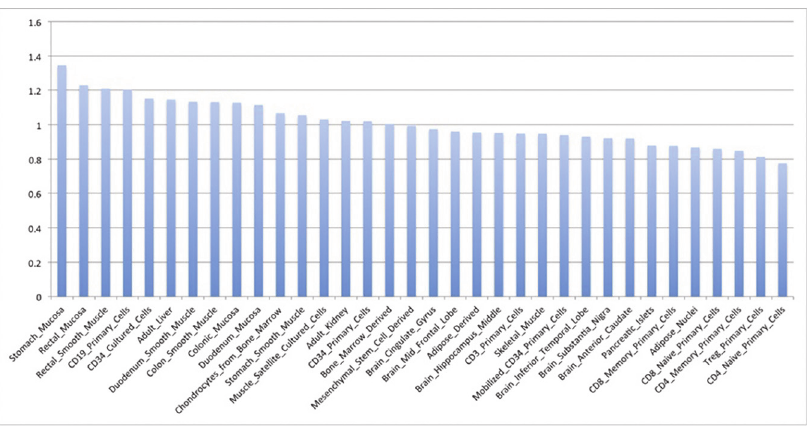
Fig 1. Enrichment of HPV integration sites inside regions marked by H3K4me3 in different cell types. Enrichment for a given cell type is calculated based on overlap between H3K4me3 chip-seq peaks for the cell type and HPV integration sites including 10kb flanks in both directions. Enrichment values are further normalized as described in Methods.